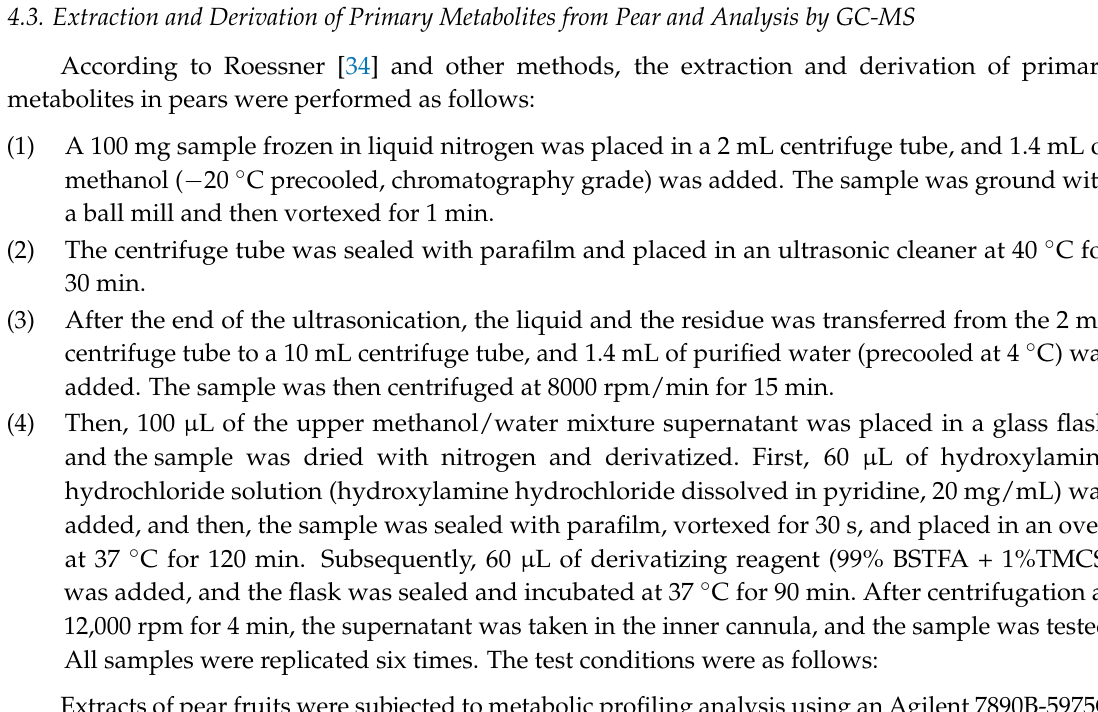
Table 6. Standard information and standard curves for intermediate metabolites of lignin synthesis. Chemical Formula Standard Curve Metabolite Formula Weight Cinnamic acid C 9 H 8 O